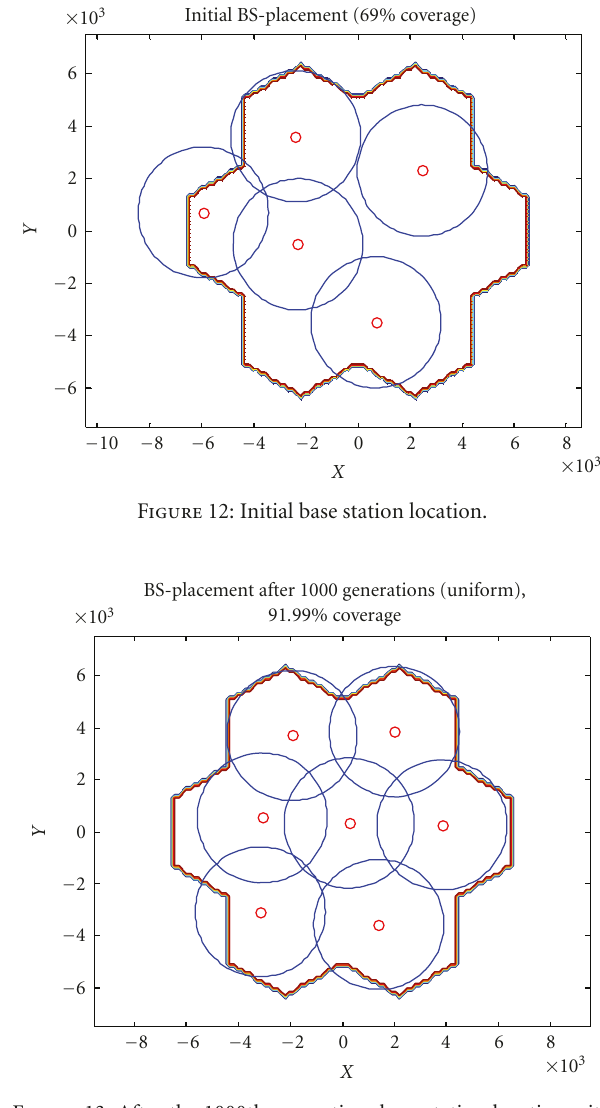
Figure 13: After the 1000th generation, base station location with uniform